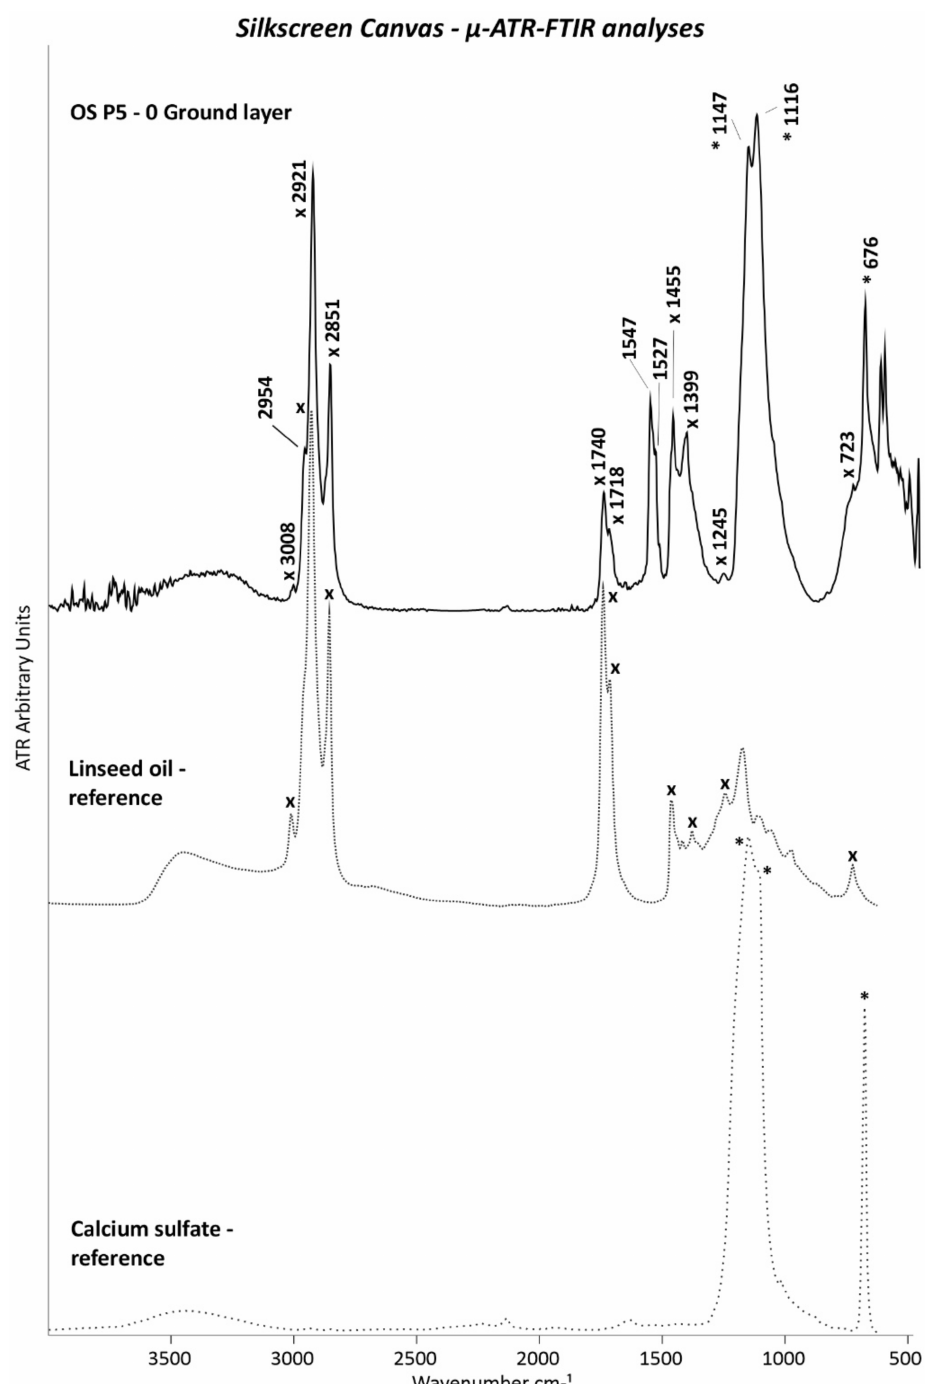
Figure 11. ATR spectra of white ground layer 0 of OS P5. The ATR spectra of the linseed oil (x) and calcium sulfate (CaSO 4 ) (*) references are also